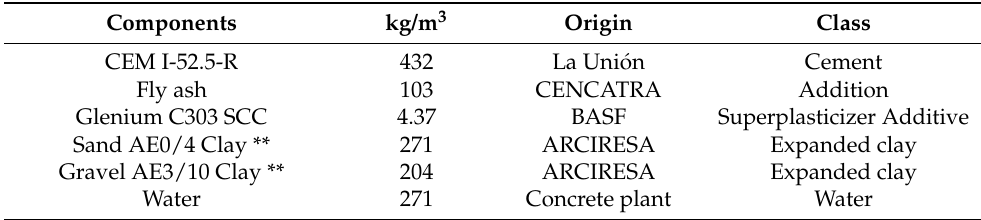
Table 4. Refractory concrete developed.